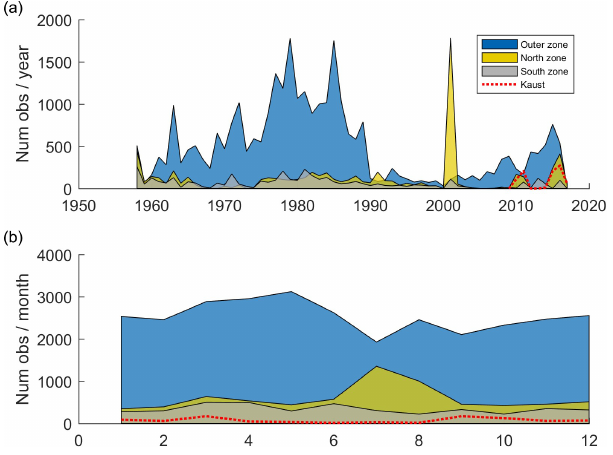
Figure 3. Number of observations per year (a) . Number of obser- vations per month (b) . North zone in yellow, South zone in grey and Outer zone in blue. Dashed line (in red) indicates the number of observations coming from the KAUST dataset.